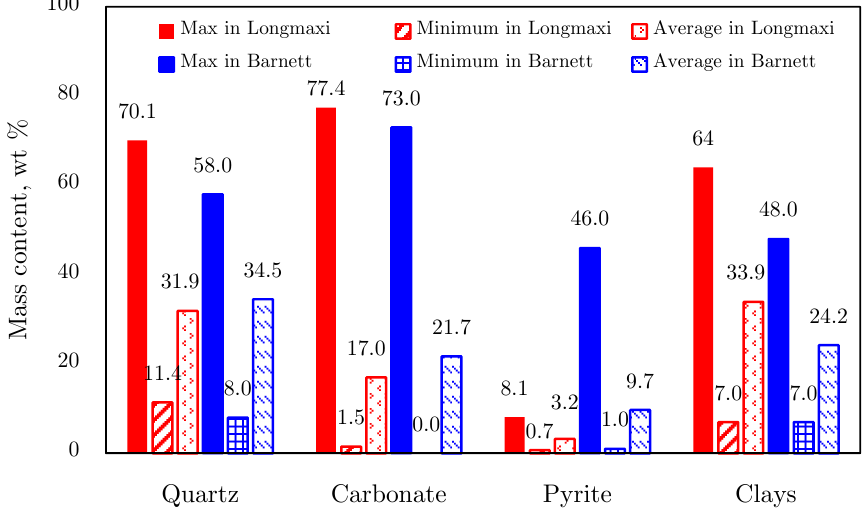
Figure 4. Comparison of mineral content between shale samples from the Longmaxi Formation and the Barnett Shale [15,16].